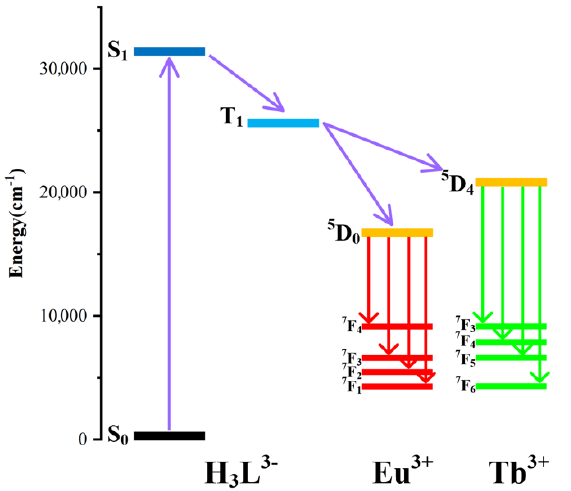
Figure 6. Energy diagram showing the calculated S 0 , S 1 and T 1 states of Li 3 H 3 L model (at TD-DFT B3LYP 6–31 + G(d) level of theory) and energy levels of Eu 3+ and Tb 3+